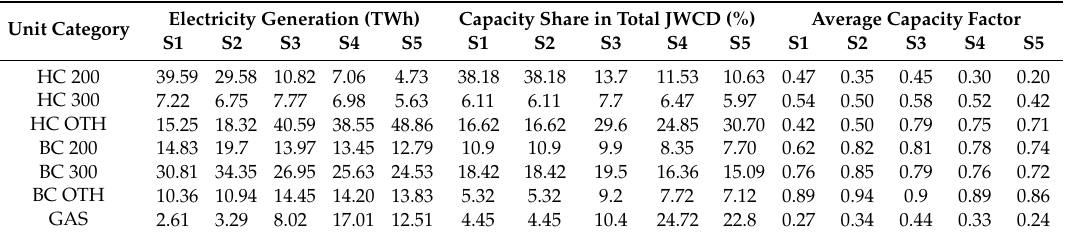
Table 7. Results: general unit performance indicators.